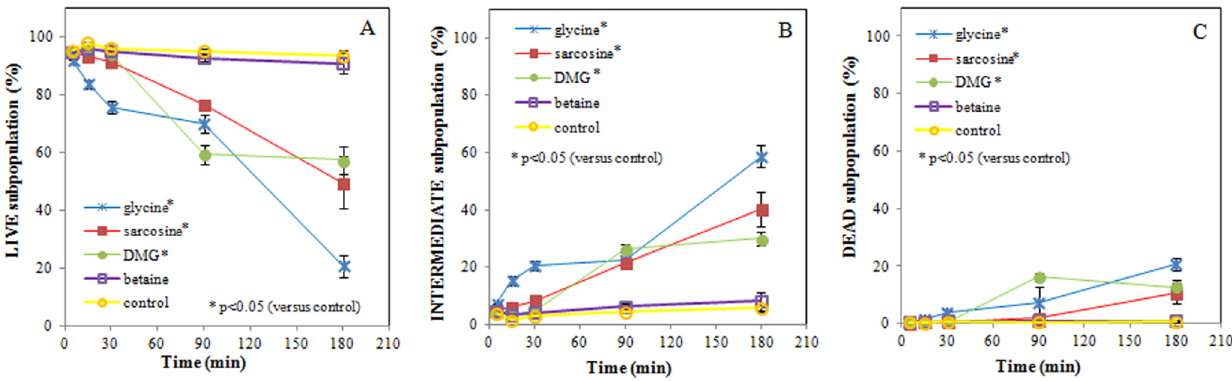
Figure 4. Percentage of membrane-intact live (A), membrane-damaged ‘‘intermediates’’ (B) and irreversibly membrane-damaged dead (C) E . coli subpopulations. ETEC were exposed to glycine, sarcosine, DMG, betaine (50 mM, pH 9.5) and sterile PBS (control, pH 9.5) for up to 180 minutes Data are expressed as means 6 SD of triplicate experiments.